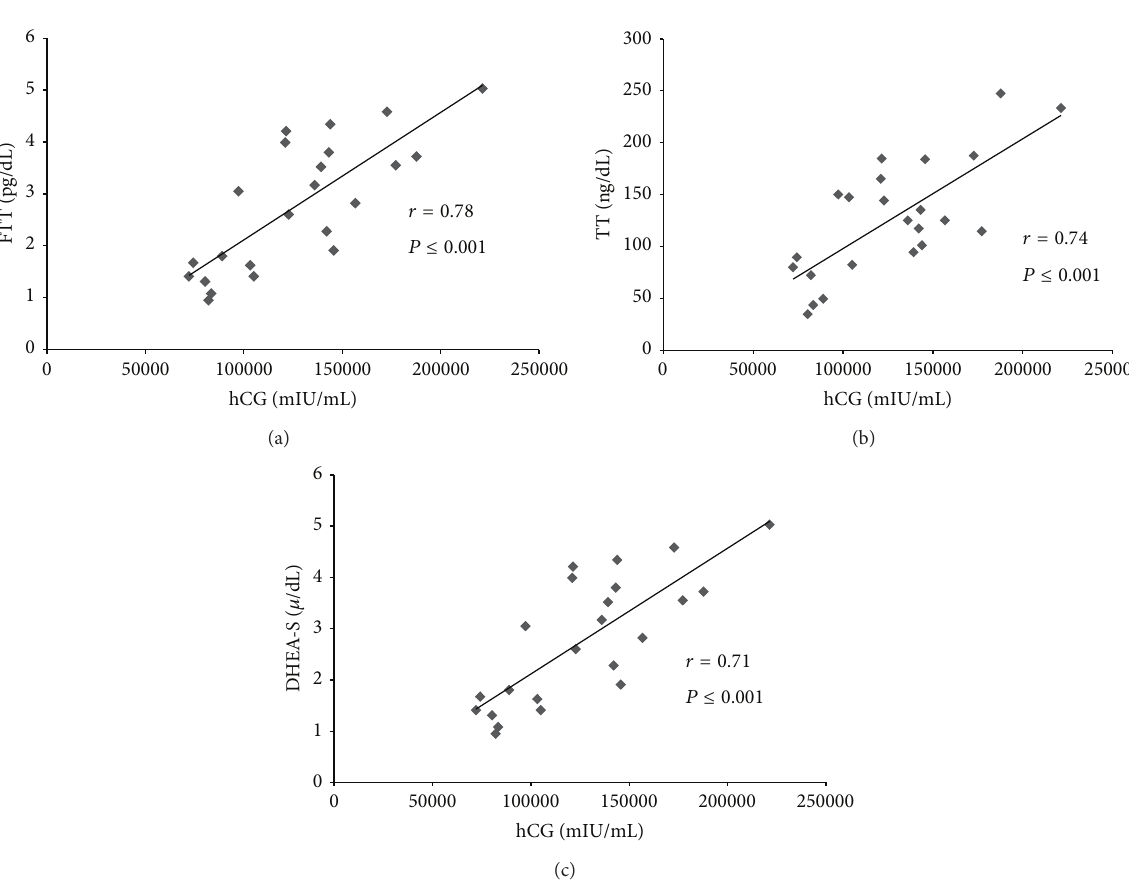
Figure 1: Coefficient of correlation between (a) hCG and free testosterone (FT), (b) hCG and total testosterone (TT), and (c) hCG and dehydroepiandrosterone sulfate